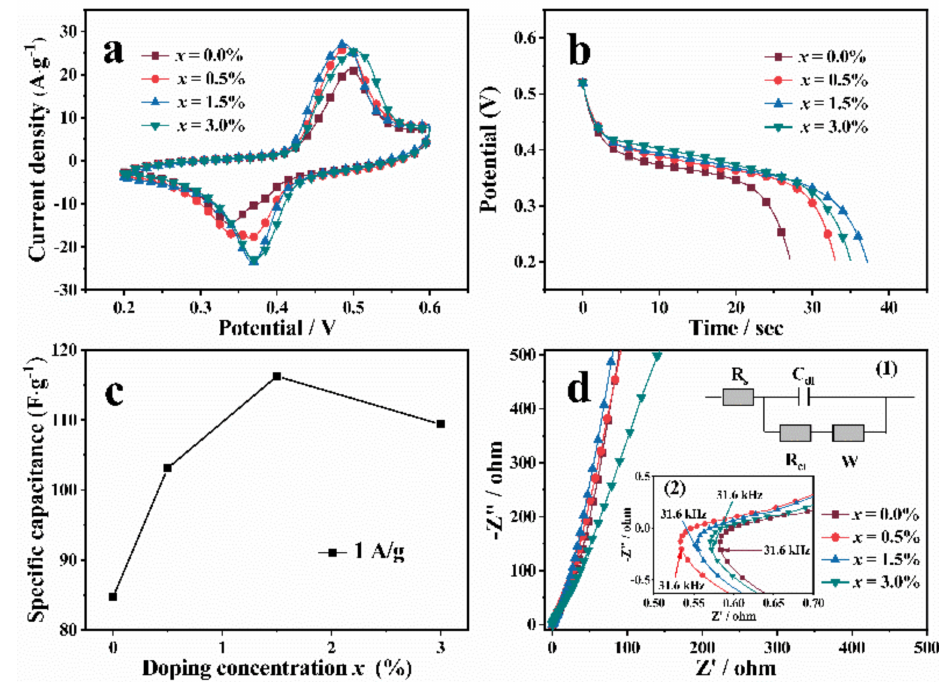
Figure 6. The Electrochemical performance of Zn-VO 2 (B) electrodes with different x values: ( a ) CV curves at the scan rate of 100 mV · s − 1 ; ( b ) Potential vs. time for discharge profiles at the current density of 1 A · g − 1 ; ( c ) Specific capacitance of samples at 1 A · g − 1 ; ( d ) Nyquist plots curves; illustration (1) is equivalent circuit diagram; illustration (2) is amplifying high frequency